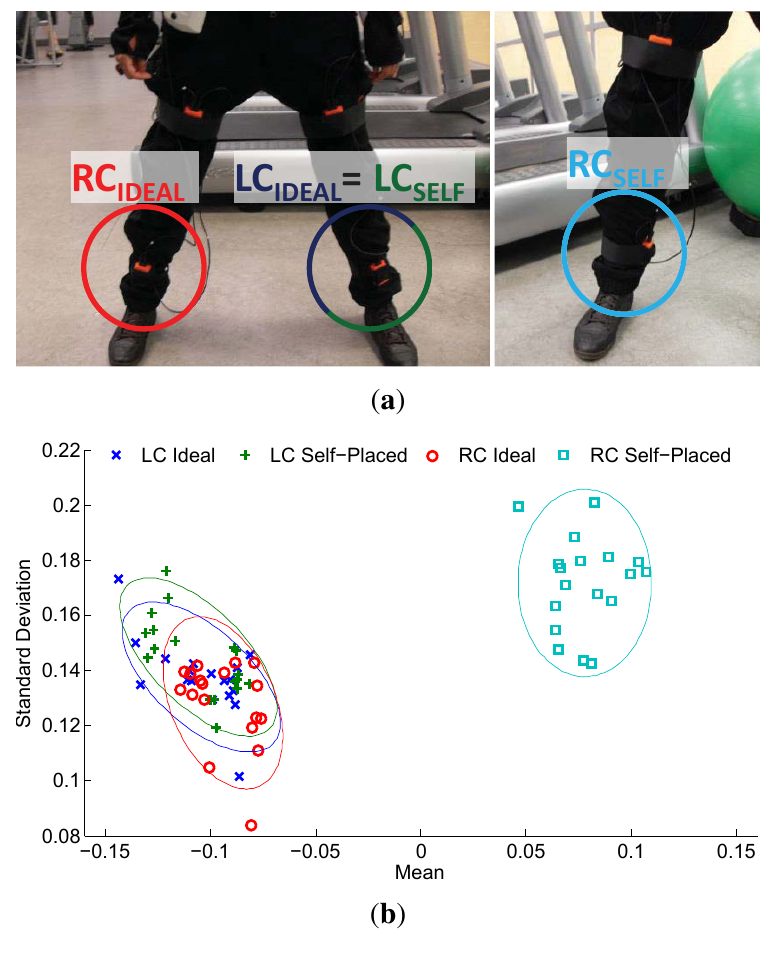
Figure 1. Example of sensor displacement introduced during the user self-placement of a sensor ( a ), and its effect at the feature level ( b ). In this particular example, the displacement with respect to the predefined deployment in the self-placement case applies to the right calf (RC), while the placement remains approximately similar for the sensor attached to the left calf (LC). In ( b ), the mean and standard deviation computed from the sensor acceleration signals is represented for various instances of a given activity. Confidence ellipses are plotted to represent the feature distribution for each